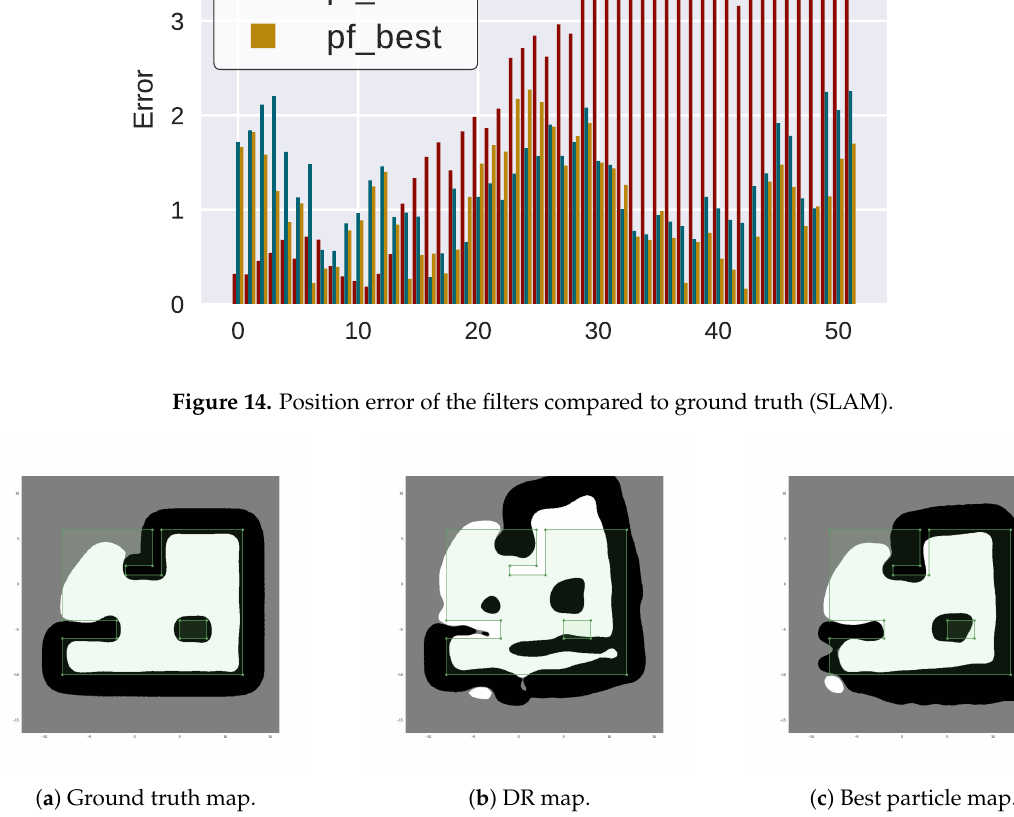
Figure 15. Comparison of HMs learned from different vehicle